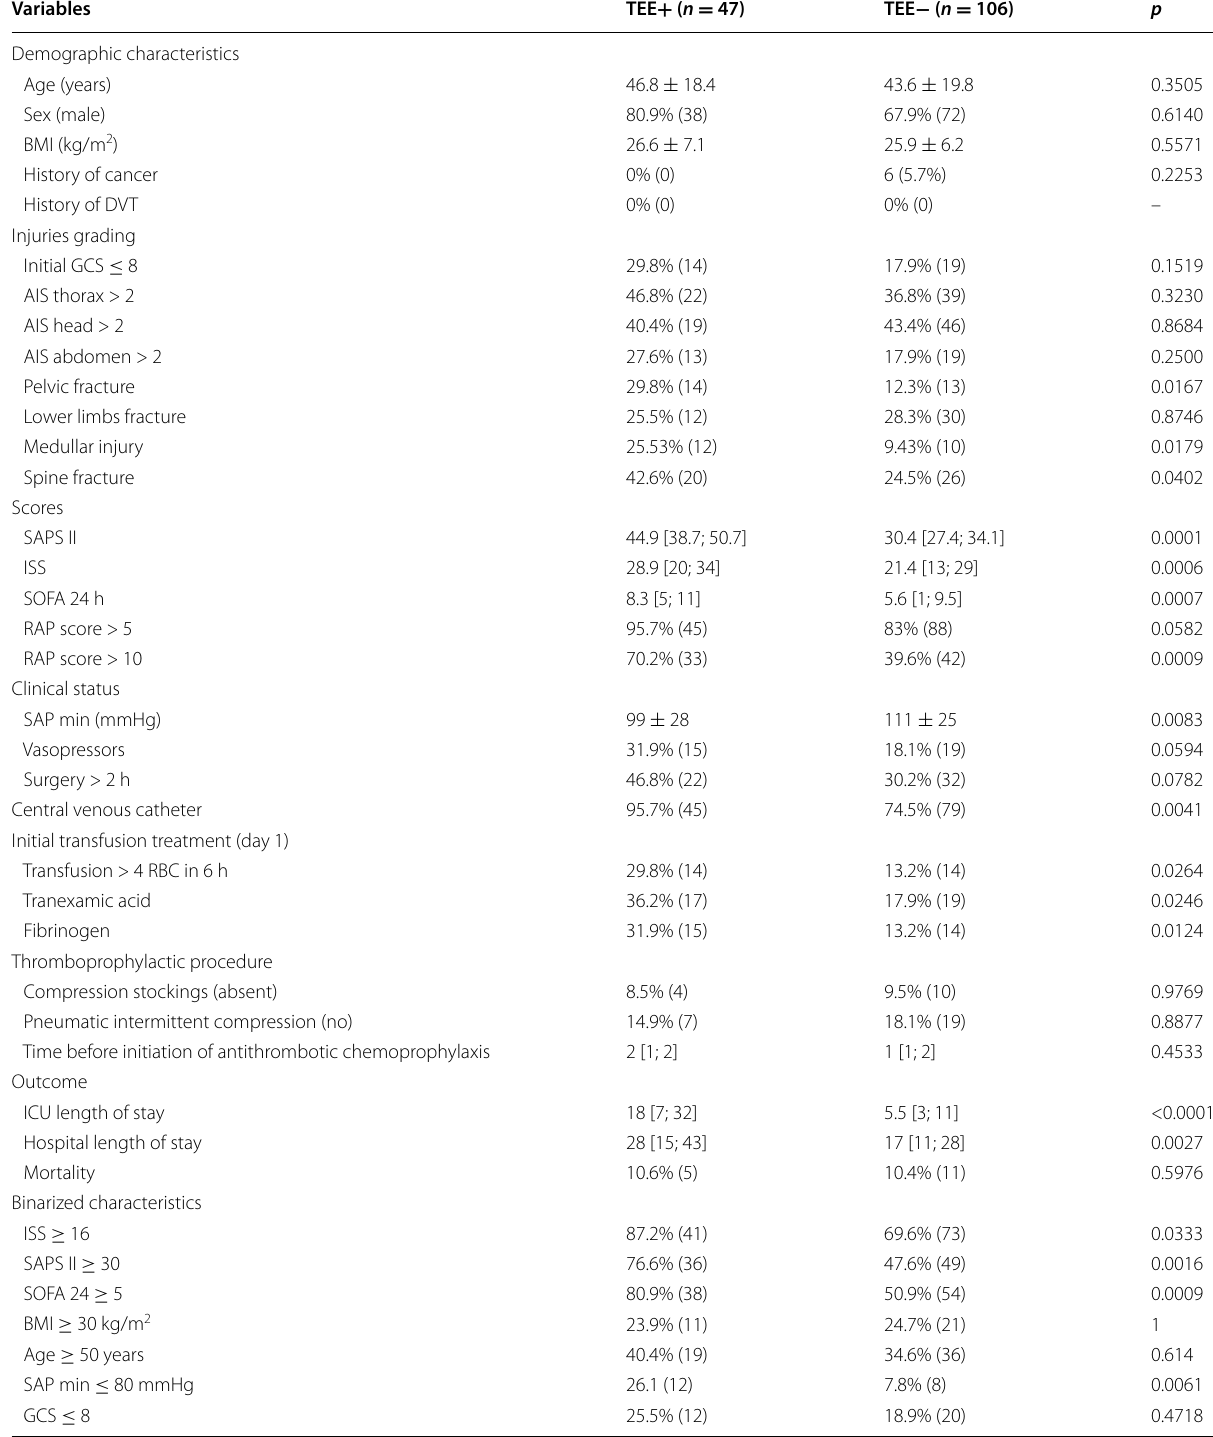
Table 3 Univariate analysis of patient characteristics according to the occurrence of thromboembolic events